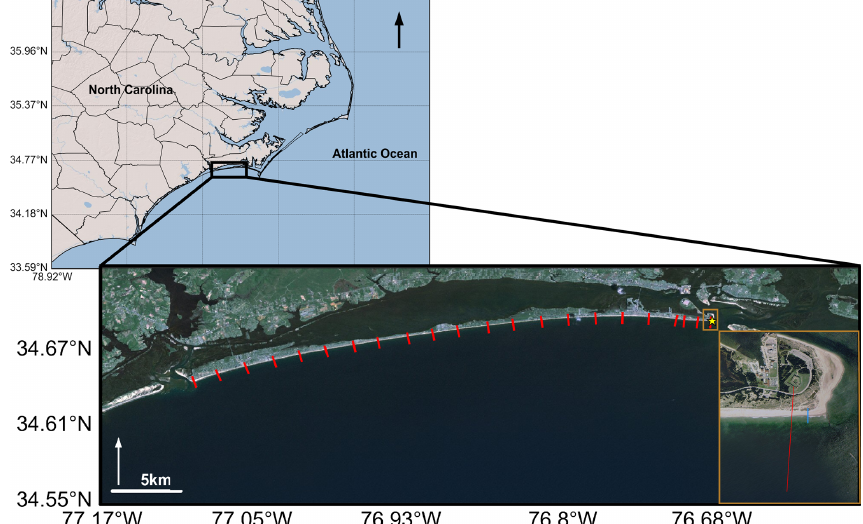
Figure 2. Map of Bogue Banks, North Carolina showing the locations of the field transects used in this study (red) and the location of the LiDAR profile (yellow star) used to construct the synthetic dune profiles used in this study. The inset image shows the eastern half of Fort Macon State Park with the LiDAR profile location in blue. Figure modified from Itzkin et al. (2020a). Aerial imagery provided by ESRI.